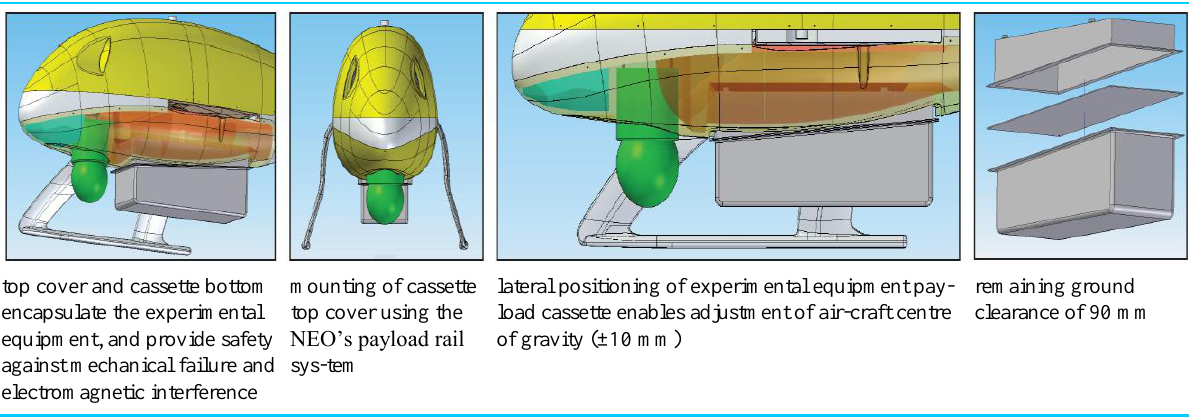
Fig. 5 Payload Cassette Safety Concept to encapsulate Experimental Equipment